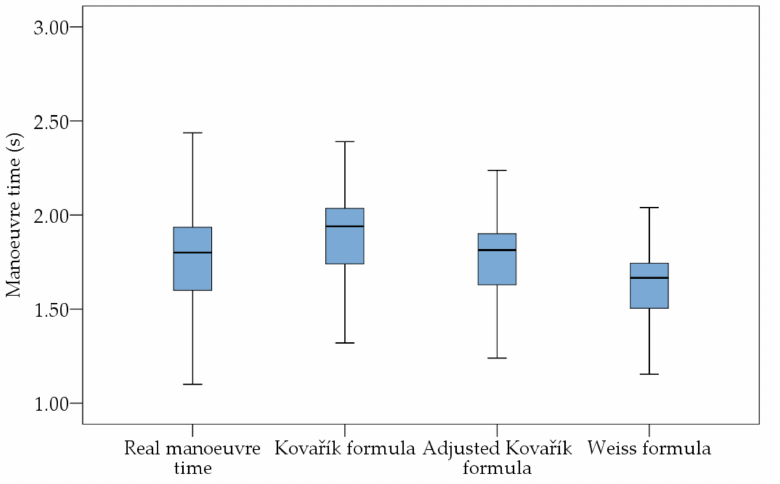
Figure 4. Equation comparison.